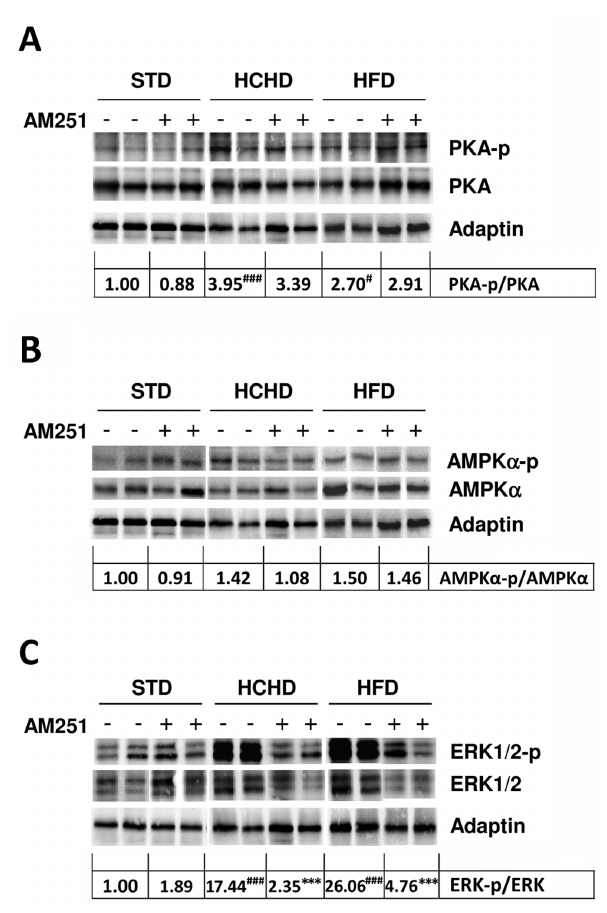
Figure 6. Effect of obesogenic diets and AM251 on PKA, AMPK and ERK phosphorylation status in PrAT. Western blot analysis of the phosphorylation status of the PKA enzyme ( A ) AMPK ( B ) and ERK1/2 ( C ) was determined in PrAT of STD, HCHD or HFD-fed animals treated with vehicle alone or AM251. Adaptin is shown as equal protein loading control. The ratio of densitometric values of the PKA-p/PKA, AMPK-p/ AMPK and ERK-p/ERK bands are shown at the bottom of the respective blots. Differences between diets were analyzed by one-way ANOVA and Bonferroni’s post-hoc test, and comparisons between groups treated with AM251 or vehicle were analyzed by Student’s t test. # p , 0.05 and ### p , 0.001 denote significant differences compared with the STD- fed group treated with vehicle (set as 1). *** p , 0.001 denotes significant differences compared with the corresponding vehicle-treated group.